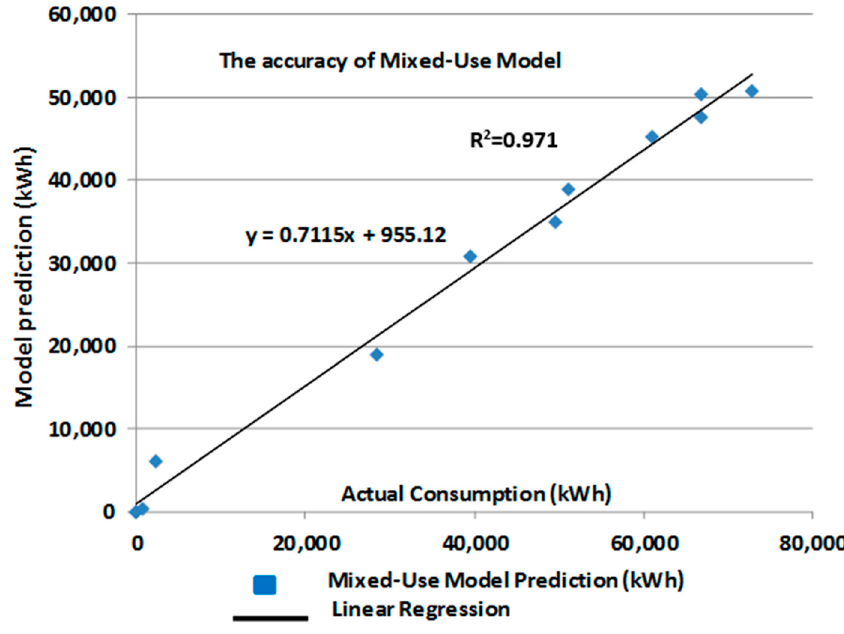
Figure 5. R-squared assessment to control the accuracy of the model.